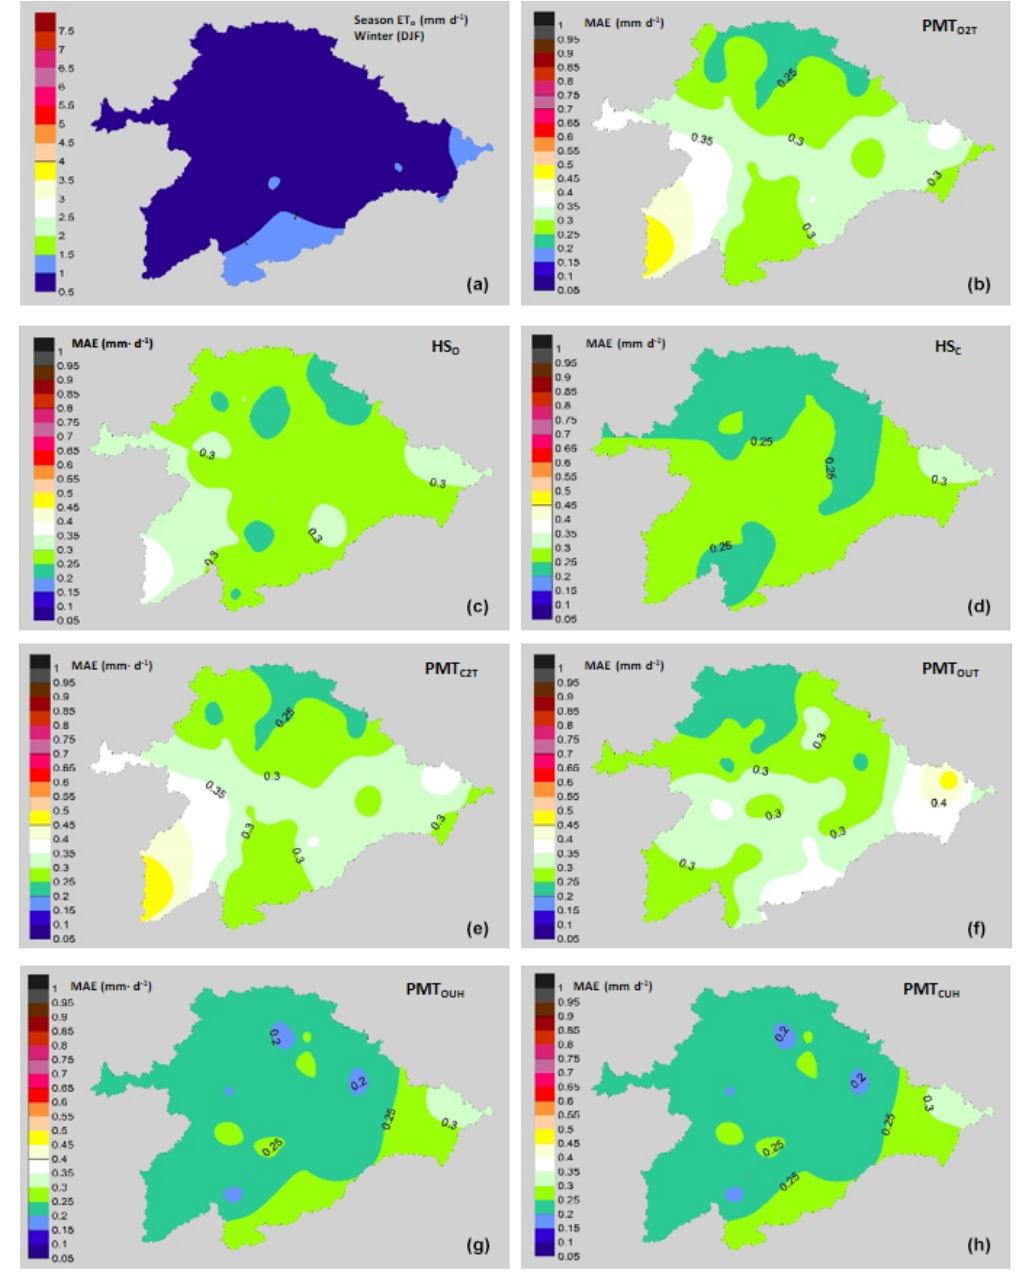
Figure 4. Performance of the models with a winter focus (December, January and February). (a) Average values of ET o (mmd − 1 ) in winter. Mean values of MAE (mmd − 1 ): (b) PMT O2T model, (c) H O model, (d) H C model, (e) PMT C2T model, (f) PMT OUT model, (g) PMT OUH model and (h) PMT CUH